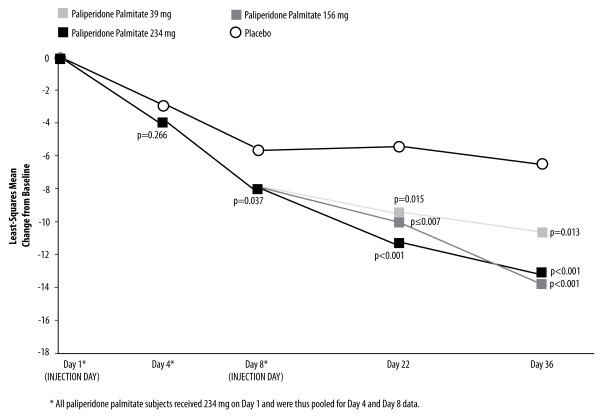
Changes in PANSS Total Scores Over Time (LOCF) in the ITT Analysis Set (p-values for Paliperidone Palmitate vs. Placebo). The administration of paliperidone palmitate 234 mg on Day 1 was associated with a significantly greater improvement than placebo on mean PANSS total score at the Day 8 assessment (LS mean [SE] change from baseline -8.21 [0.87] vs. -5.79 [1.20], p = 0.037). In a dose-dependent fashion, all paliperidone palmitate groups continued to show greater PANSS total score improvement than placebo at subsequent timepoints.